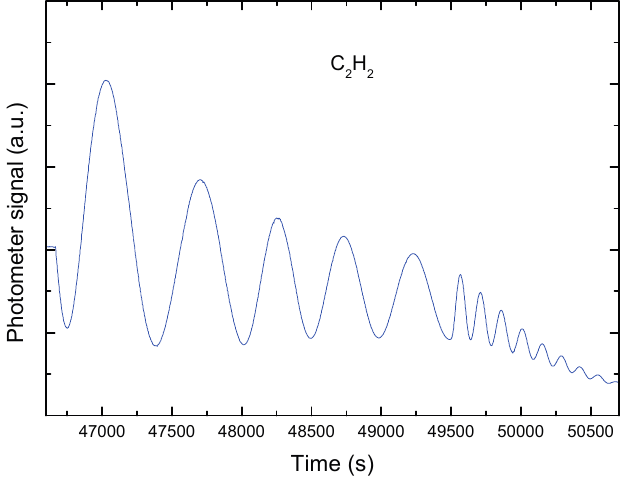
Figure 9. Graph of interference curves produced over time when using a single laser during gas-phase